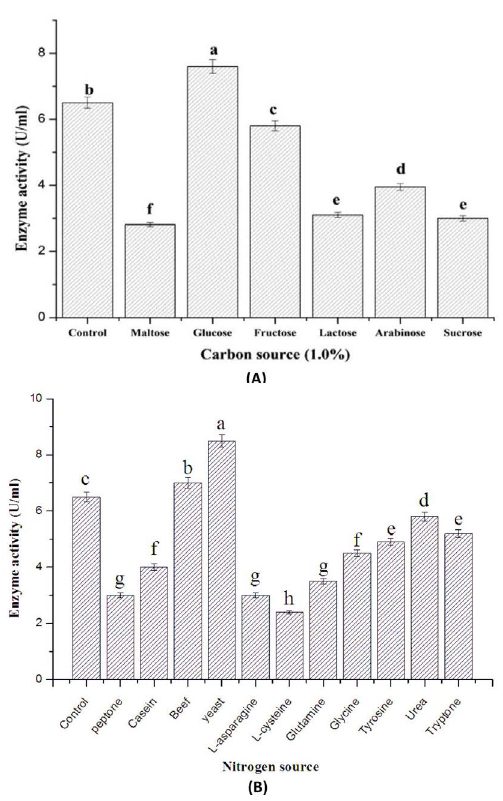
Fig. 1. Effect of supplementation of different carbon sources (A) and nitrogen sources (B) on laccase production by S. mutabilis A17 strain under solid state fermentation.